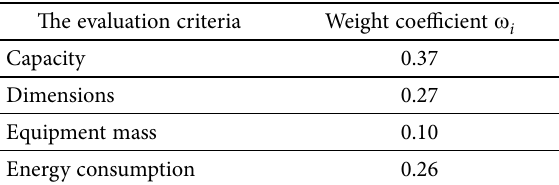
Table 4. The ballast water treatment methods